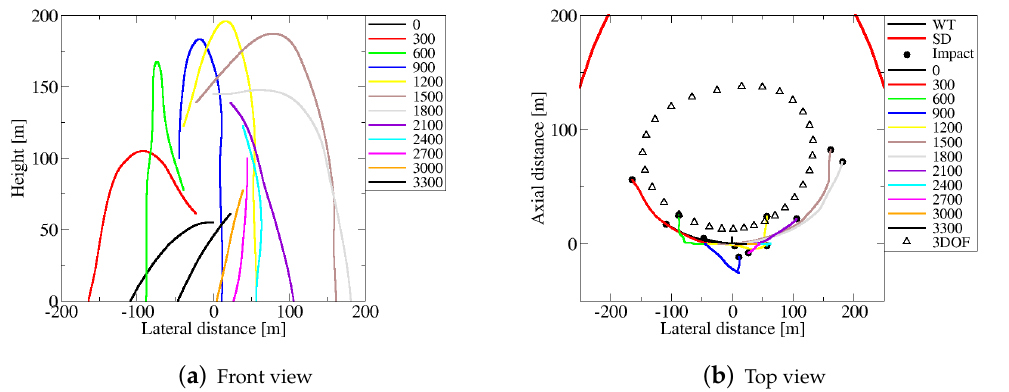
Figure 14. Trajectories from a rotating wind turbine. Computations based on DB1.